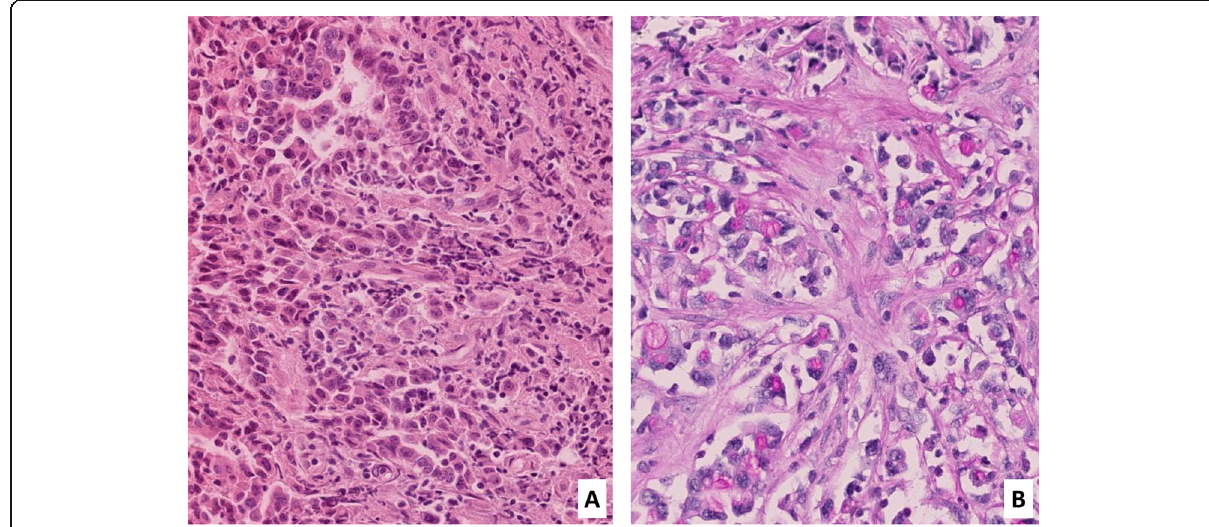
Fig. 1 Cytopathological analysis. A Cytopathological analysis showing malignant cells with focal gland formation (cell block - Hematoxylin-Eosin (HE) x20). B The PAS-Diastase coloration confirmed the presence of mucin in the malignant cells